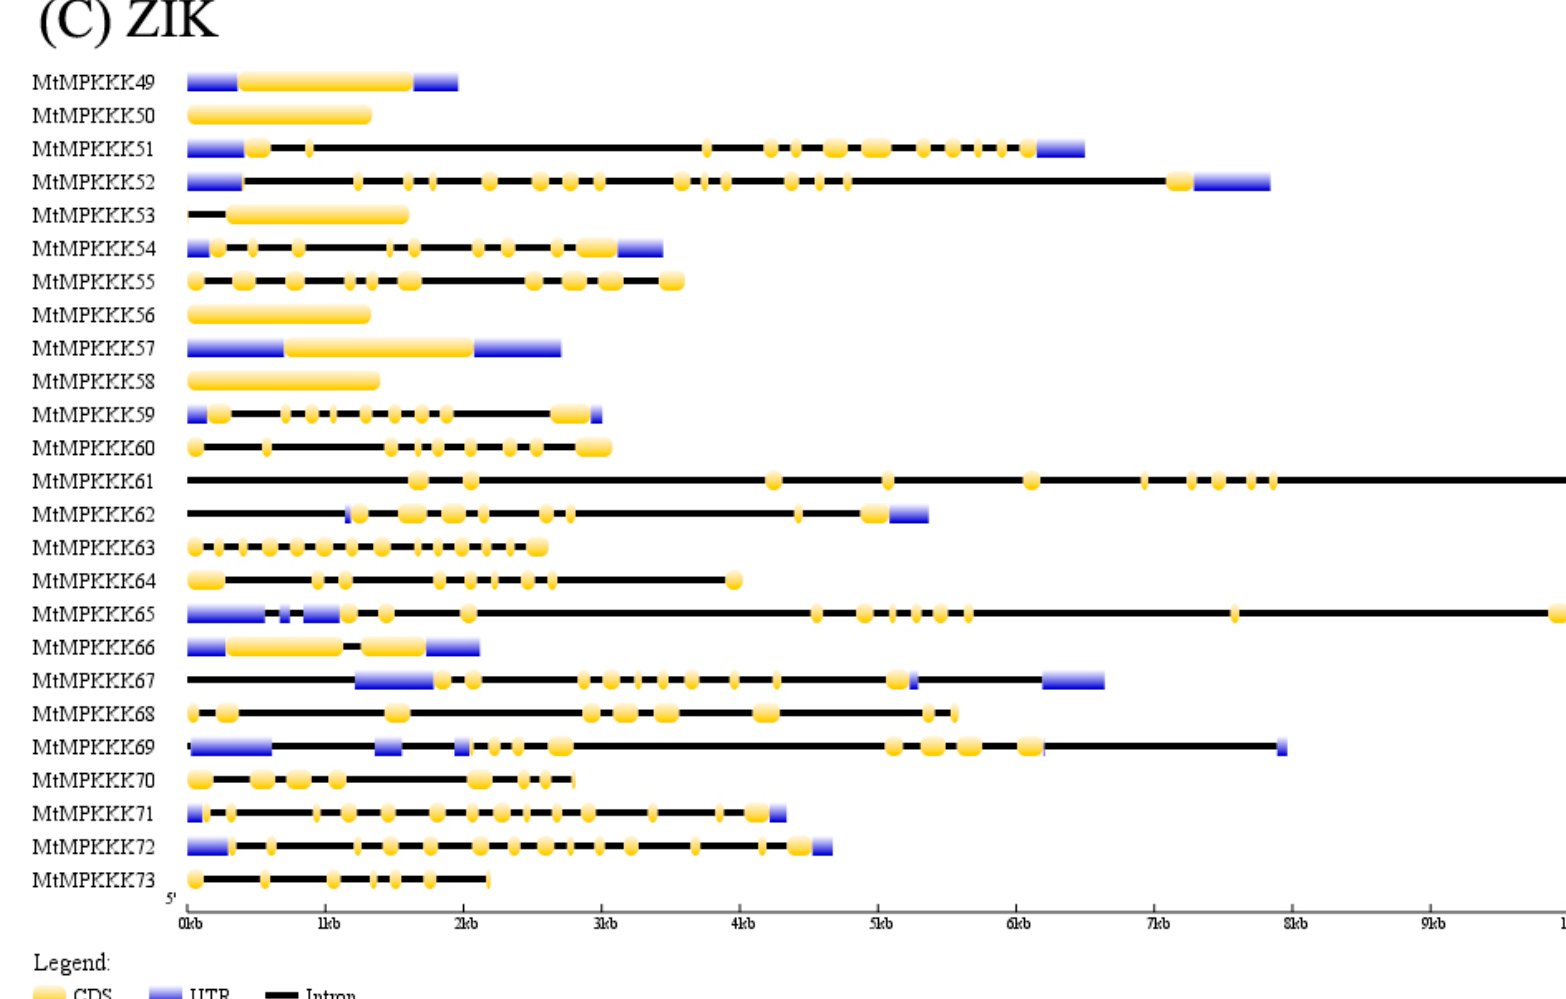
Figure 1. The gene structure analysis of MAPKKK gene family in Medicago truncatula . (A) MEKK subfamily; (B) RAF subfamily; (C) ZIK subfamily.